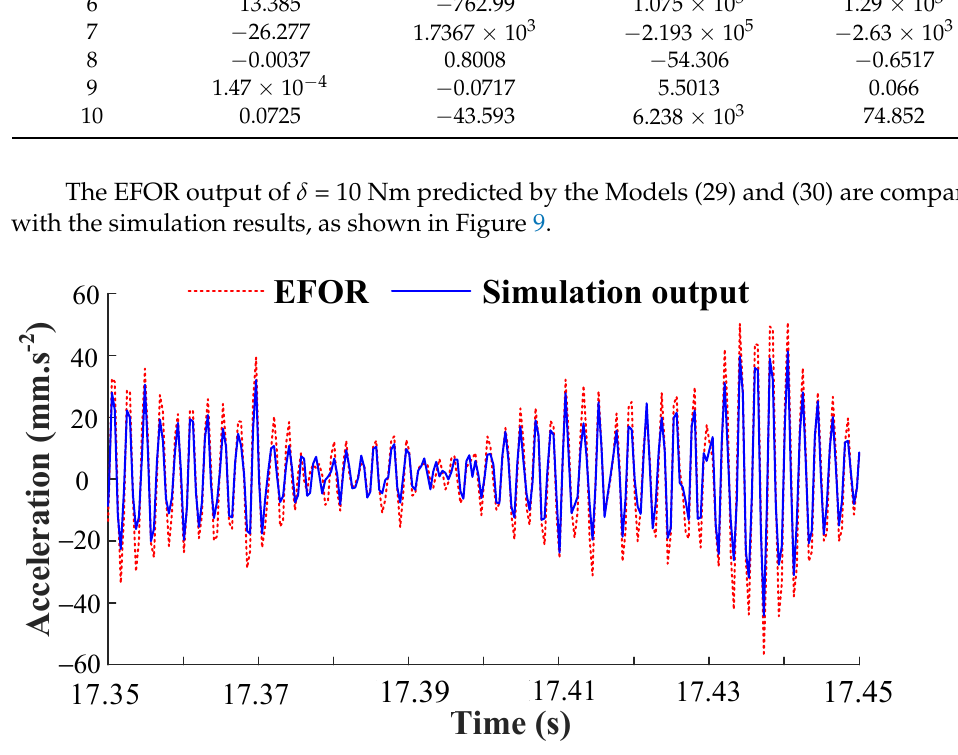
Figure 9. Comparison between the EFOR output and the simulation output by MPO.